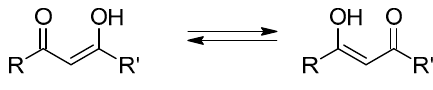
Figure 7. Keto–enol tautomer equilibrium.